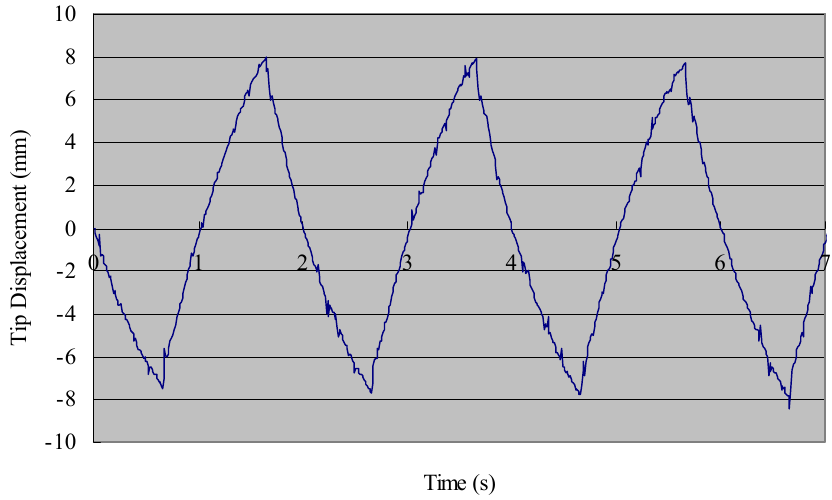
Figure 7. Experimental deflection of IPMC with time (square stimulus).